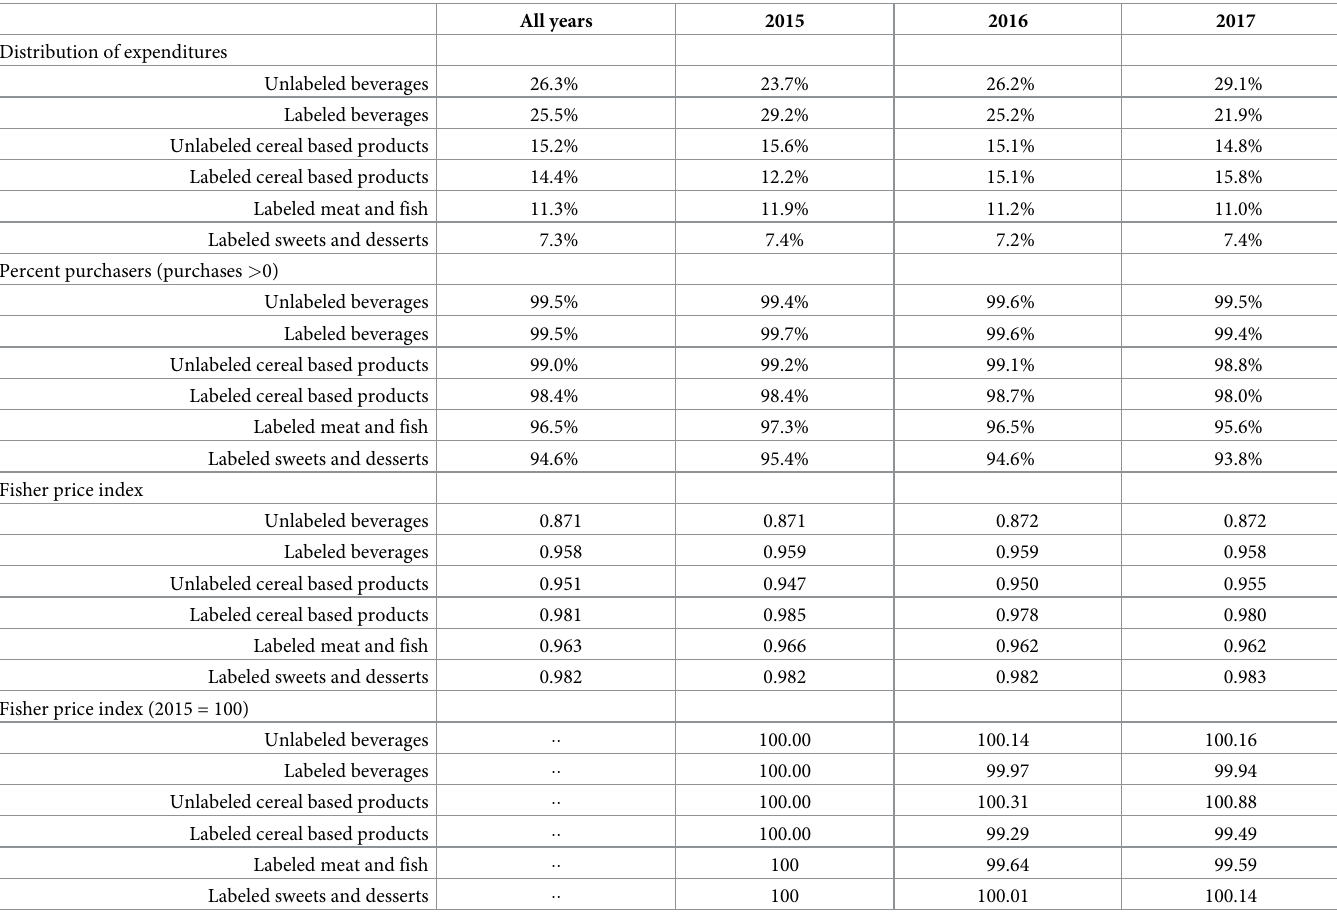
Table 1. Distribution of expenditures, percent purchasers and Fisher Price Index by food and beverage group and calendar year,